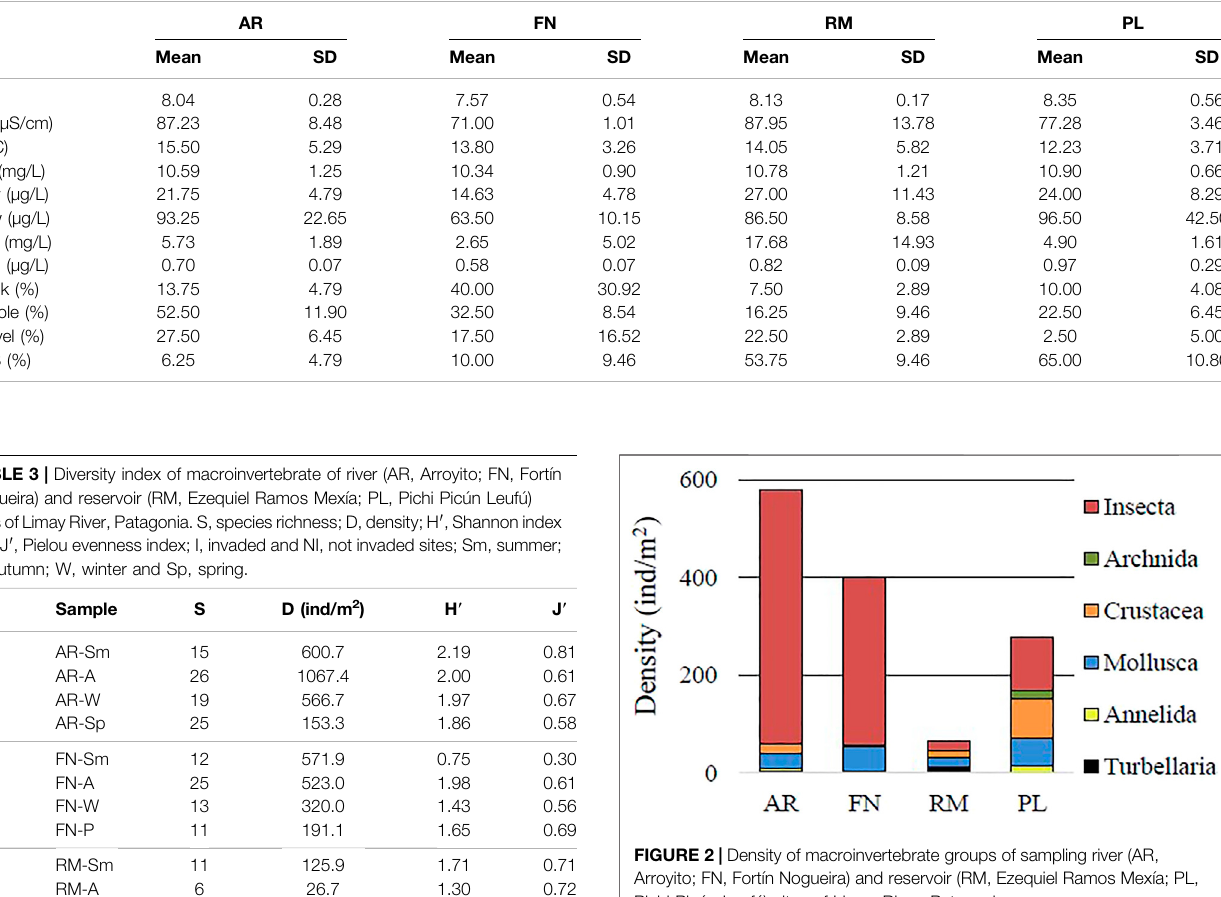
TABLE 2 | Physical-chemical variables of sampling river (AR, Arroyito; FN, Fortín Nogueira) and reservoir (RM, Ezequiel Ramos Mexía; PL, Pichi Picún Leufú) sites of Limay River,Patagonia.SD,standarddeviation;EC,electricalconductivity;T,Temperature;DO,dissolvedoxygen;TP,Totalwaterphosphorus;Totalwaternitrogen(TN);TSS, Total suspended solids; Chl a , chlorophyll a; block (257 – 500 mm); pebble (65 – 256 mm); gravel (2 – 64 mm); clay + silt + sand (CSS) ( < 2 mm).